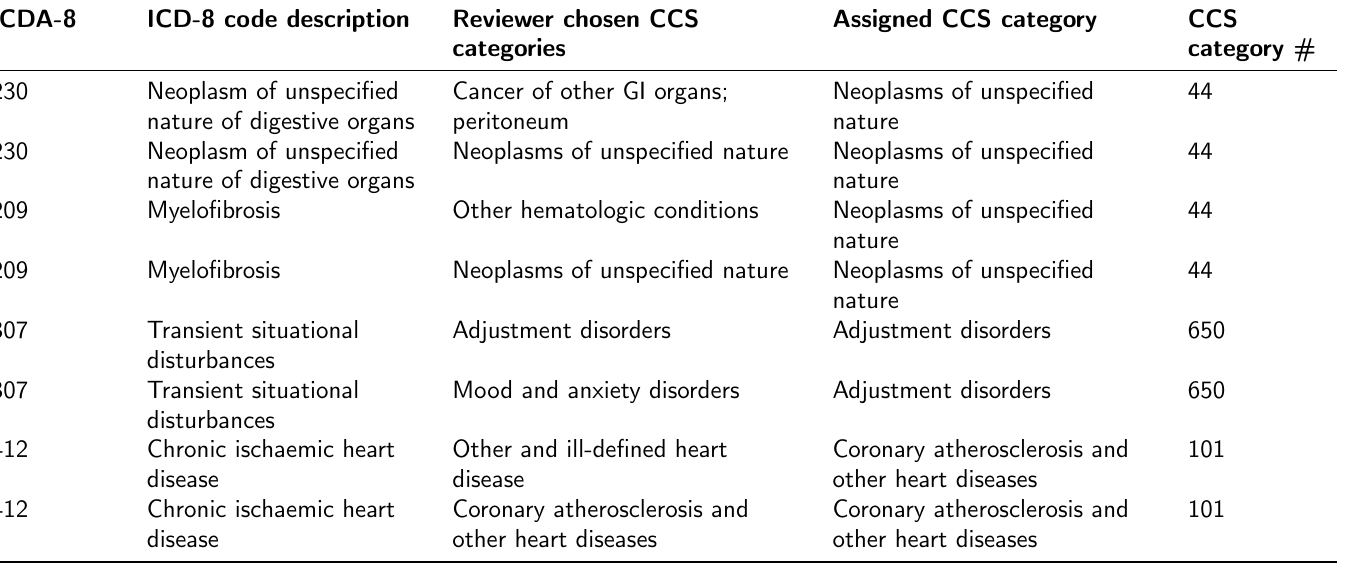
Table 2: Examples of discrepancies and final decisions in mapping ICDA-8 to CCS categories